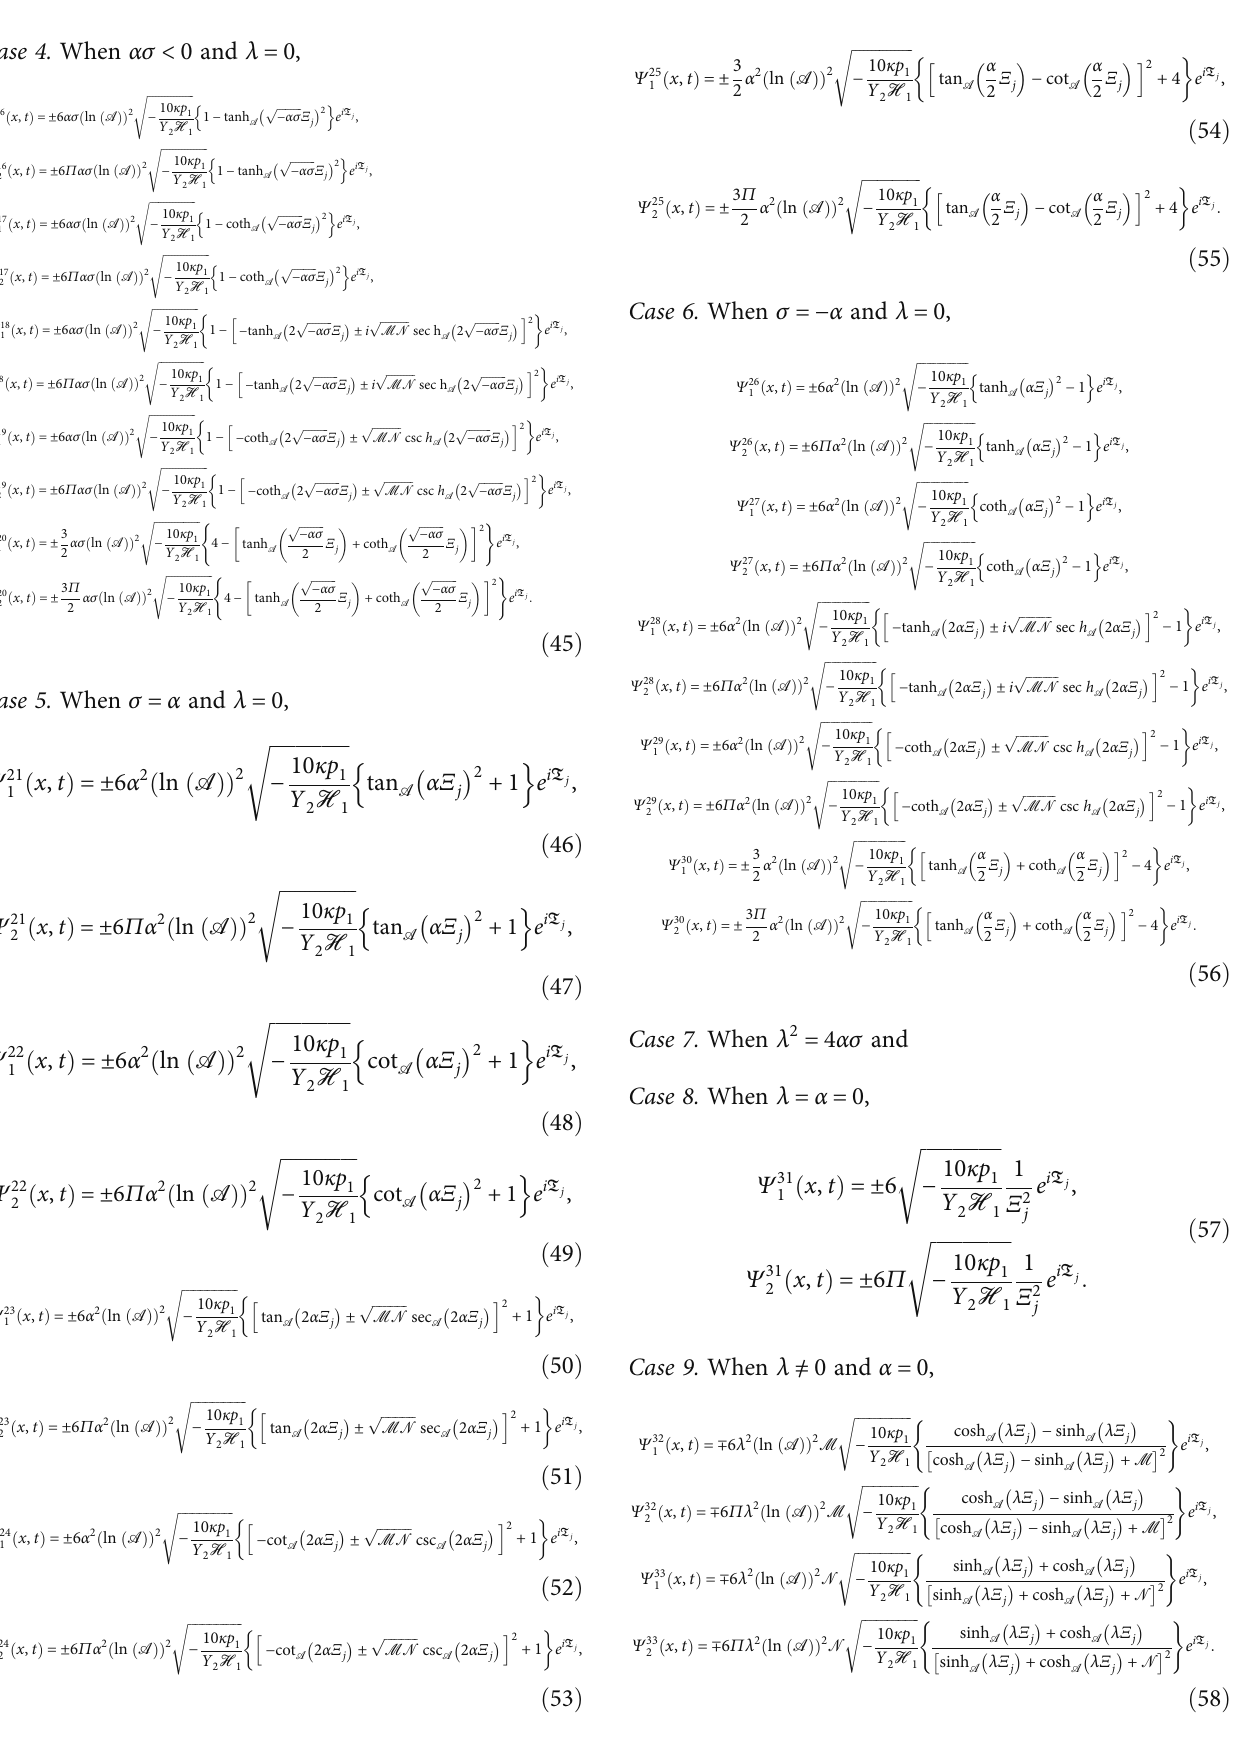
ffiffiffiffiffiffiffiffiffiffiffiffiffiffiffiffi